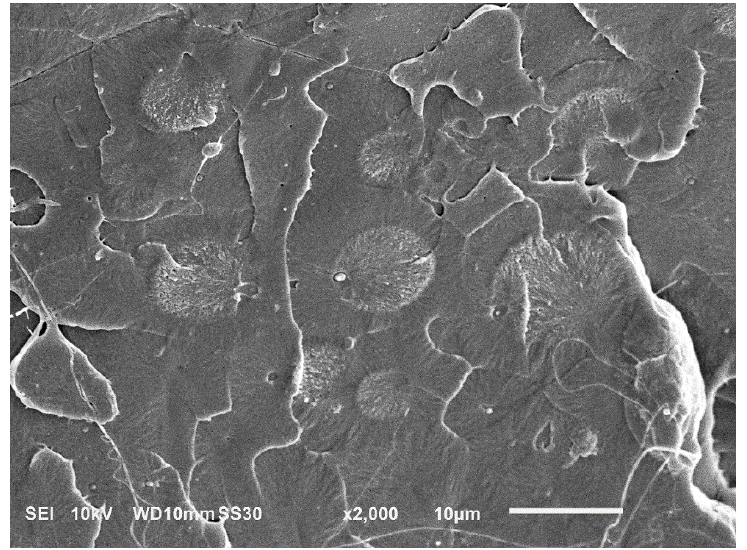
Figure 2. Scanning electron microscopy (SEM) micrograph of cryo-fracture surface of PLA/PMMA blend.